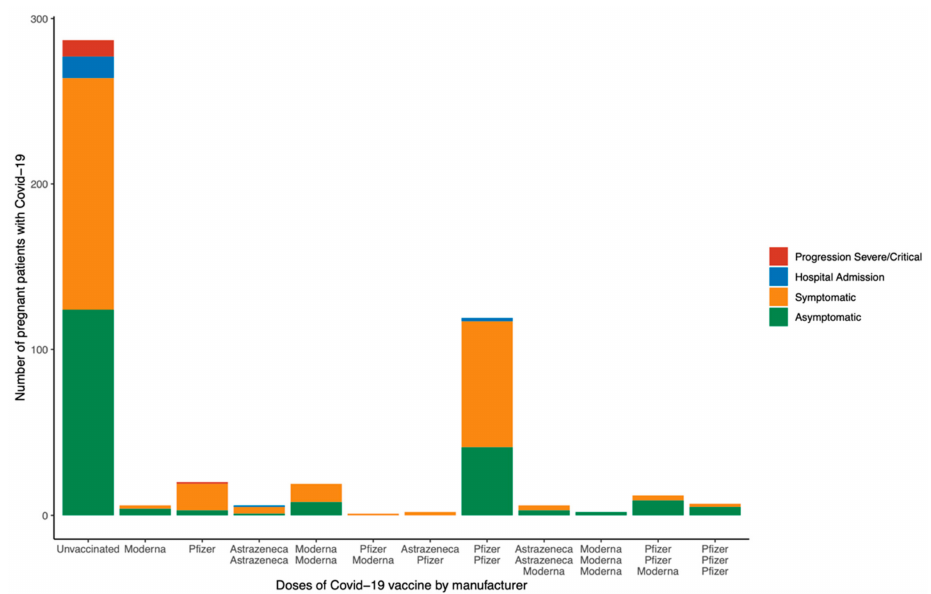
Figure 4. Progression to severe COVID-19 among vaccinated pregnant women with SARS-CoV-2 infection according to the number of doses and type of COVID-19 vaccine. Severe COVID-19 was defined as at least one of the following: admission to the intensive care unit, intuba- tion, or extracorporeal membrane oxygenation. Table 6. Odds ratios (ORs), adjusted odds ratios (aORs), and 95% confidence intervals (CIs) for perina- tal outcomes among the vaccinated and unvaccinated pregnant women with SARS-CoV-2 infection. Variable OR (95% CI) aOR (95% CI) Pneumonia 0.222